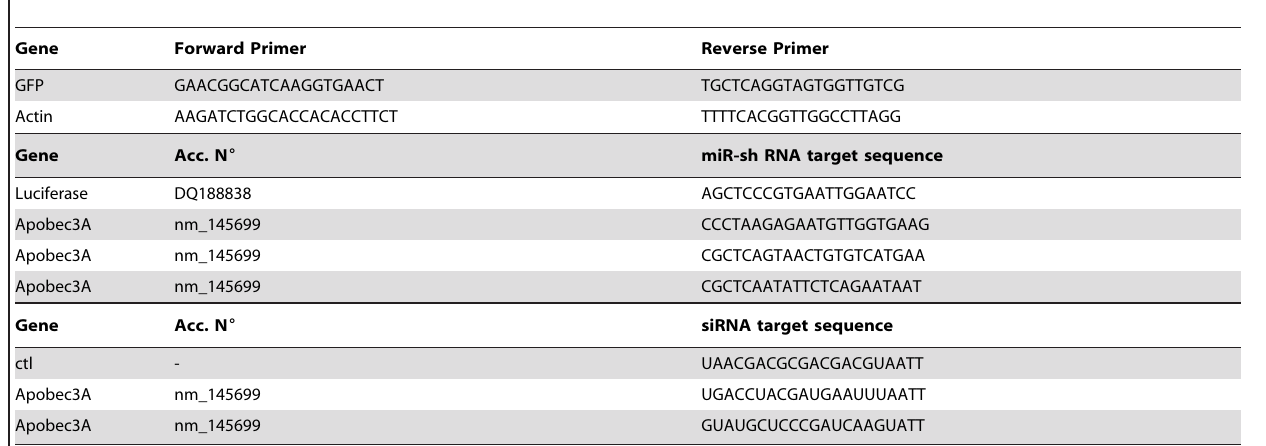
Table 1. List of primers and sequences